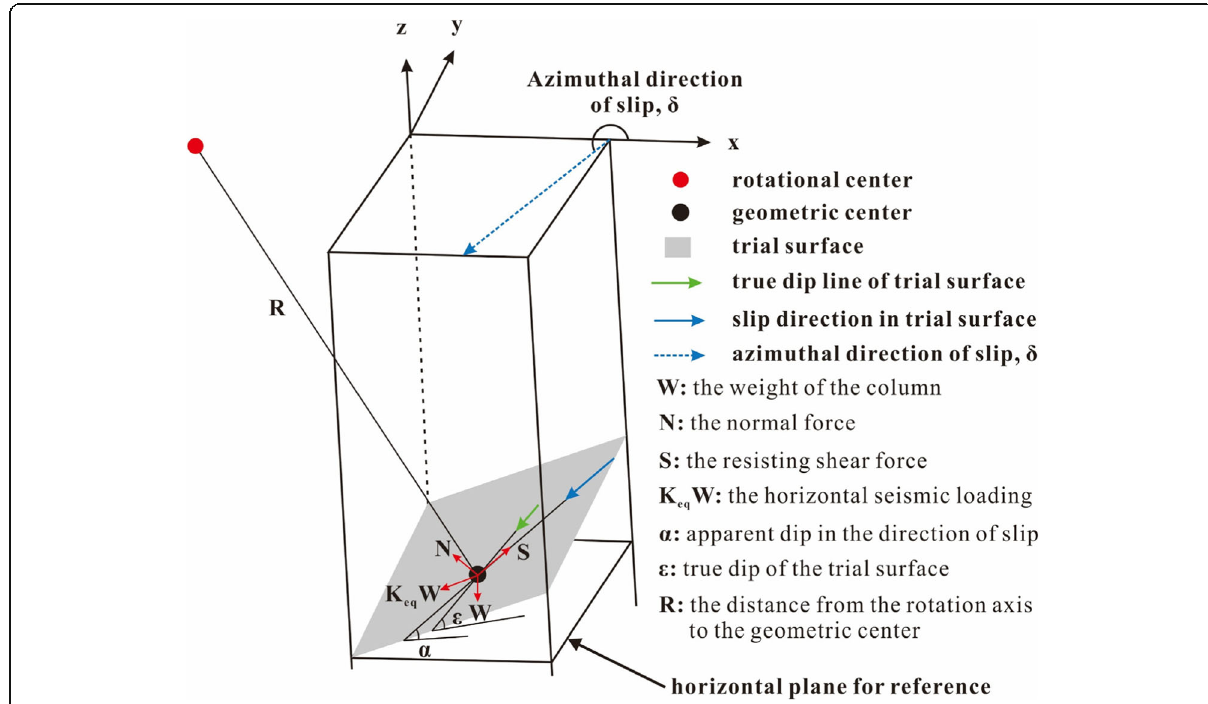
Fig. 9 Schematic diagram of forces acting on one column of (modified from Reid et al.